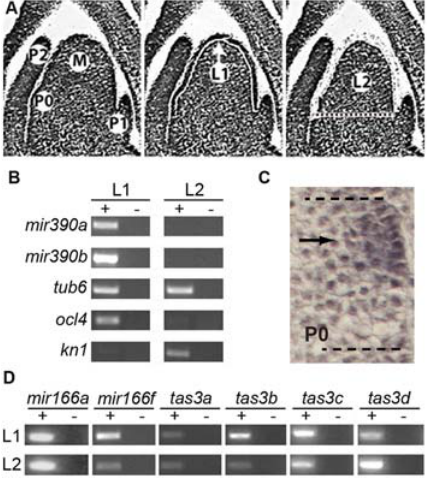
Figure 4. mir390 precursors, unlike mature miR390, accumulate in just the epidermal (L1) layer of the maize SAM. (A) Representative sections showing the laser-microdissection of the L1 epidermal layer of the SAM (M) including the incipient primordium (P0). The L1 layer is precisely cut (middle panel) and subsequently captured (right panel). Afterwards, the L2 layer is microdissected similarly. (B) RT- PCR analysis of the miR390 precursors shows that both mir390a and mir390b transcripts accumulate specifically in the L1 layer. Mutually exclusive expression of ocl4 and kn1 in the L1 and L2 layers, respectively, demonstrates the precision of LM [22,31]. (C) Close-up view of the accumulation pattern of mature miR390 in the incipient leaf (dashed lines) taken from Figure 3A. Note the presence of signal in the underlying L2 layer (arrow). ( D ) RT-PCR analysis of mir166 and tas3 family members shows these precursor transcripts accumulate in both the L1 and L2 layers of the SAM.